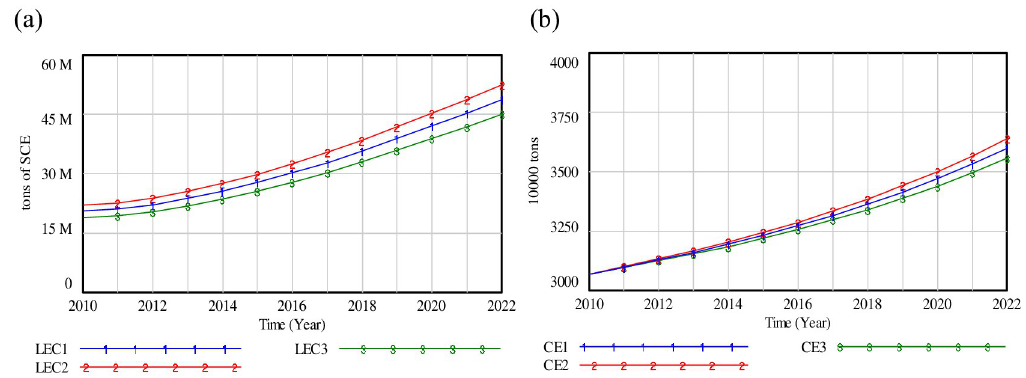
Fig 10. Simulation curves of the logistics energy consumption and carbon emissions. (a) LEC; (b) CE.